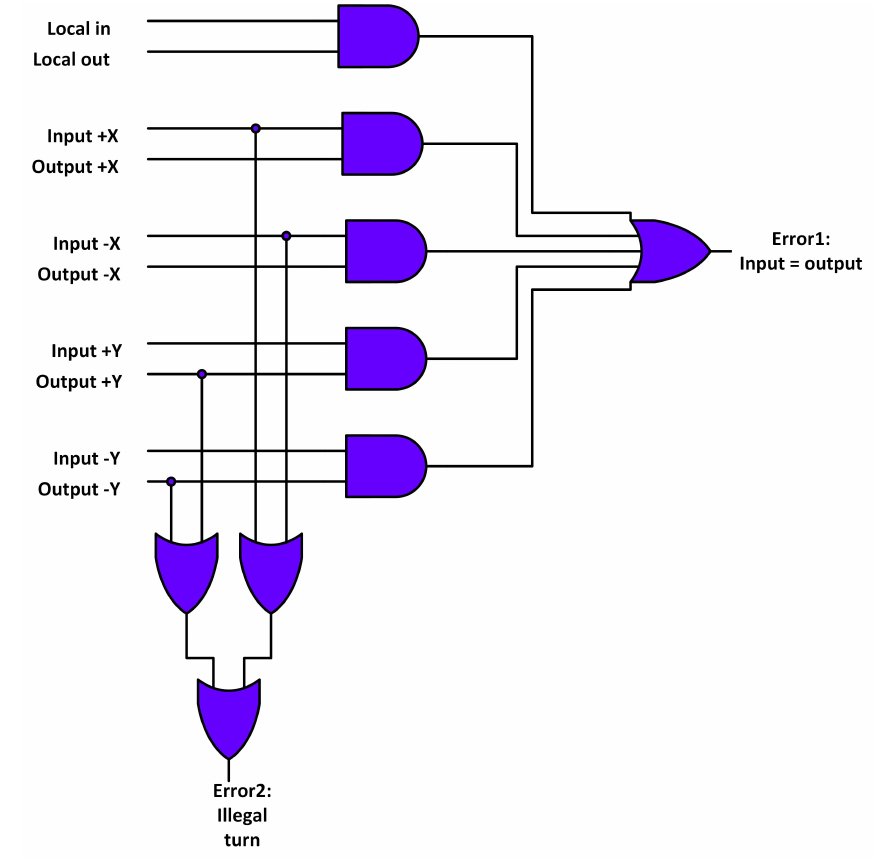
Figure 5. RC fault detection